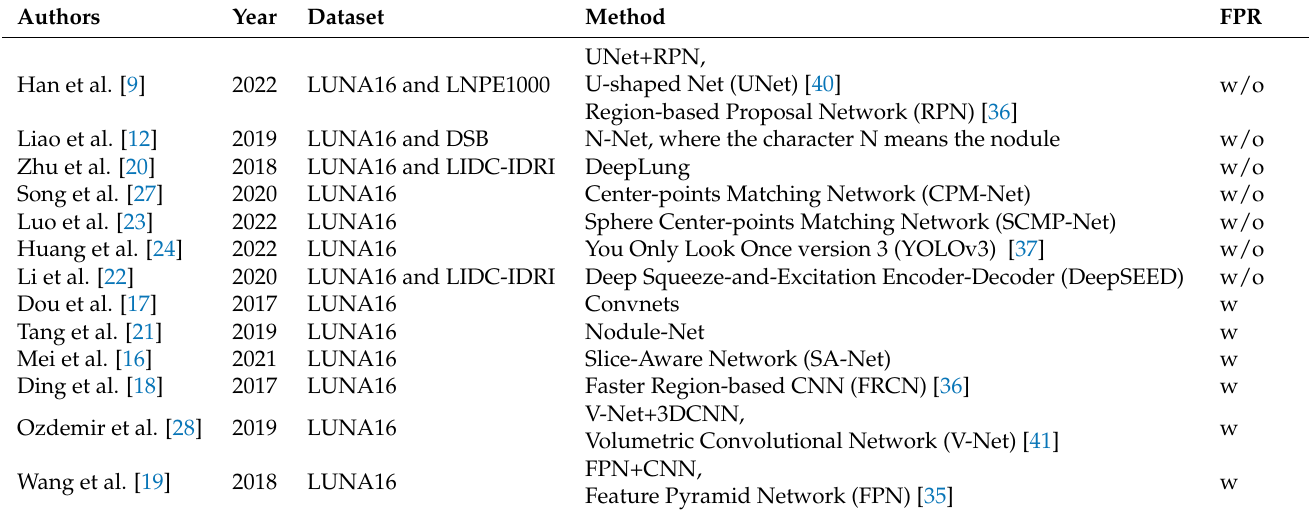
Table 1. Summary of the Related Works. False Positive Reduction (FPR). The token of ‘w’ (‘w/o’) means the listed method with (without) the FPR